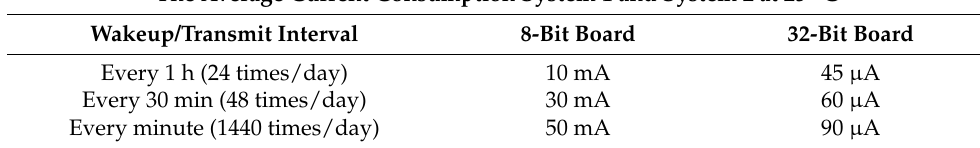
Figure 2. System board overview: ( a ) System I; ( b ) System II. Table 2. Current consumption